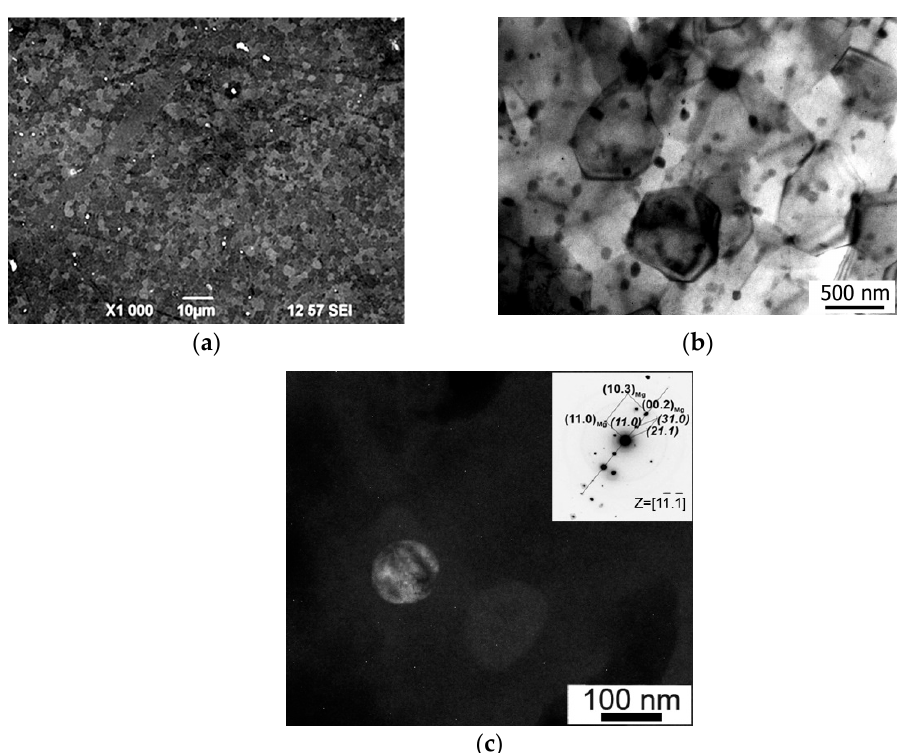
Figure 9. Structure of the Mg-1Zn-0.2Ca alloy after HPT+HT at 300 ◦ C: ( a ) SEM; ( b ) transmission electron microscopy (TEM); ( c ) dark-field image of the Ca 2 Mg 6 Zn 3 particle of a globular shape with the corresponding diffraction pattern.